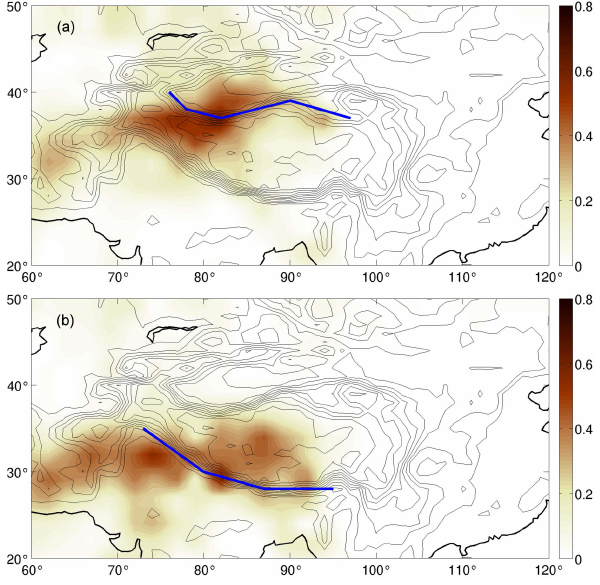
Fig. 3. Fraction of days when aerosols are blown towards the (a) northern and (b) southern slopes of the Himalaya (indicated by the blue lines) during MAM 2007, 2008, and